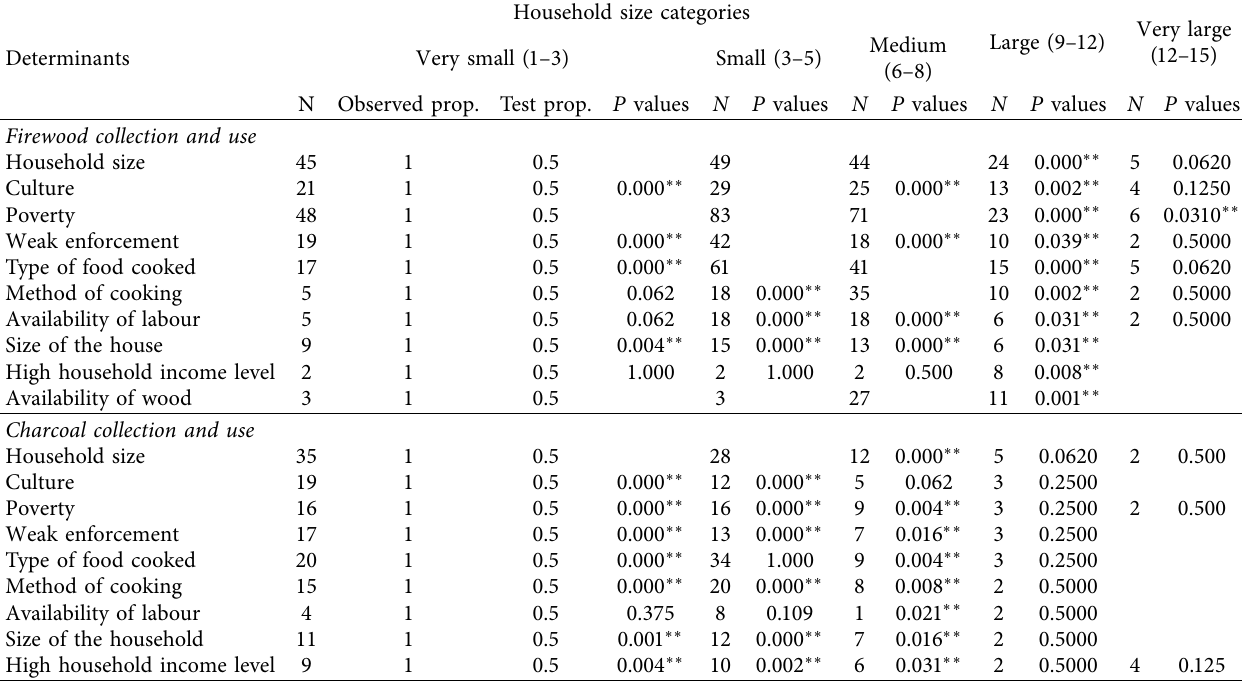
Table 2: Determinants of wood fuel collection and use by refugee household sizes.